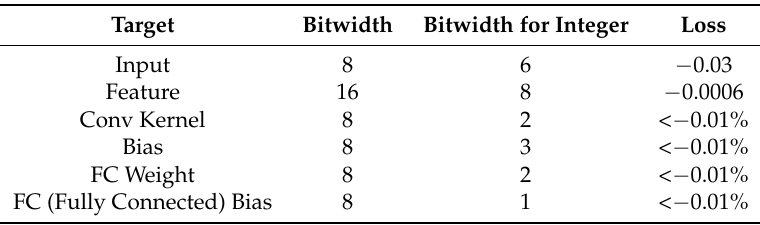
Table 6. The loss of quantization on